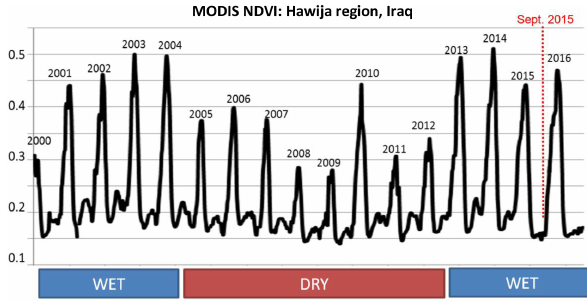
Figure 3. Time series of the 16-day NDVI for the agricultural region around Hawija, Kirkuk province, Iraq. The vertical dashed lined marks the time of the studied dust storm. Note the absence of NDVI variation in the summer of 2015, prior to the dust